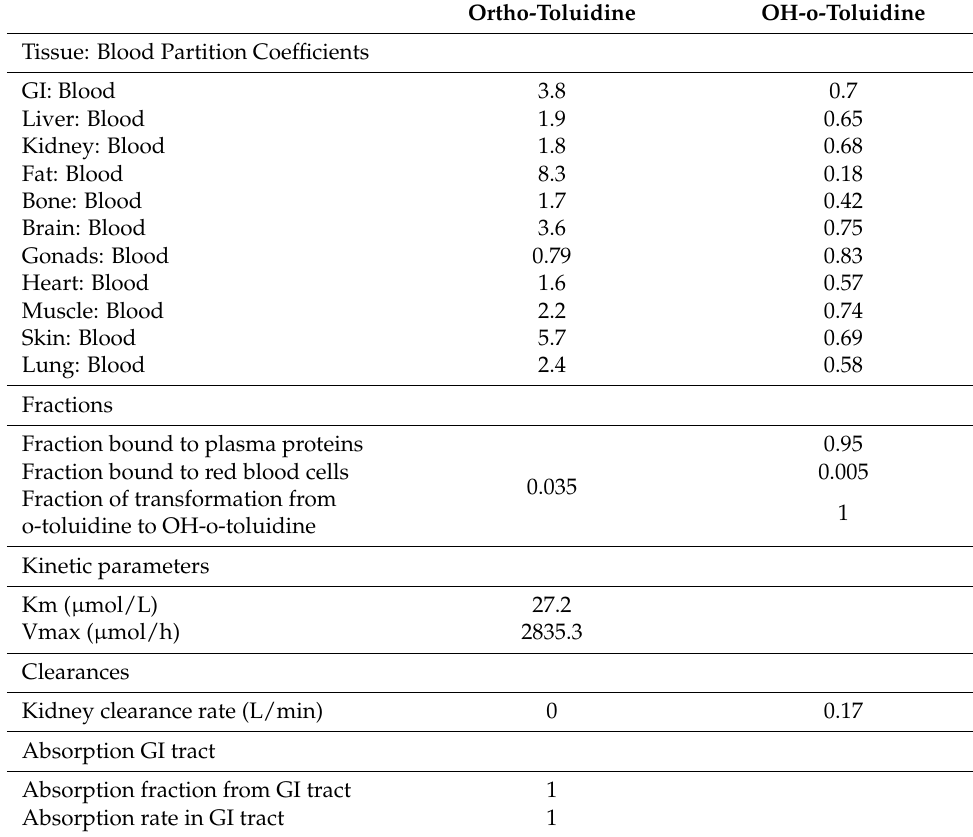
Table 1. Compound specific PBPK parameters for ortho-toluidine and the considered metabolite OH-o-toluidine.